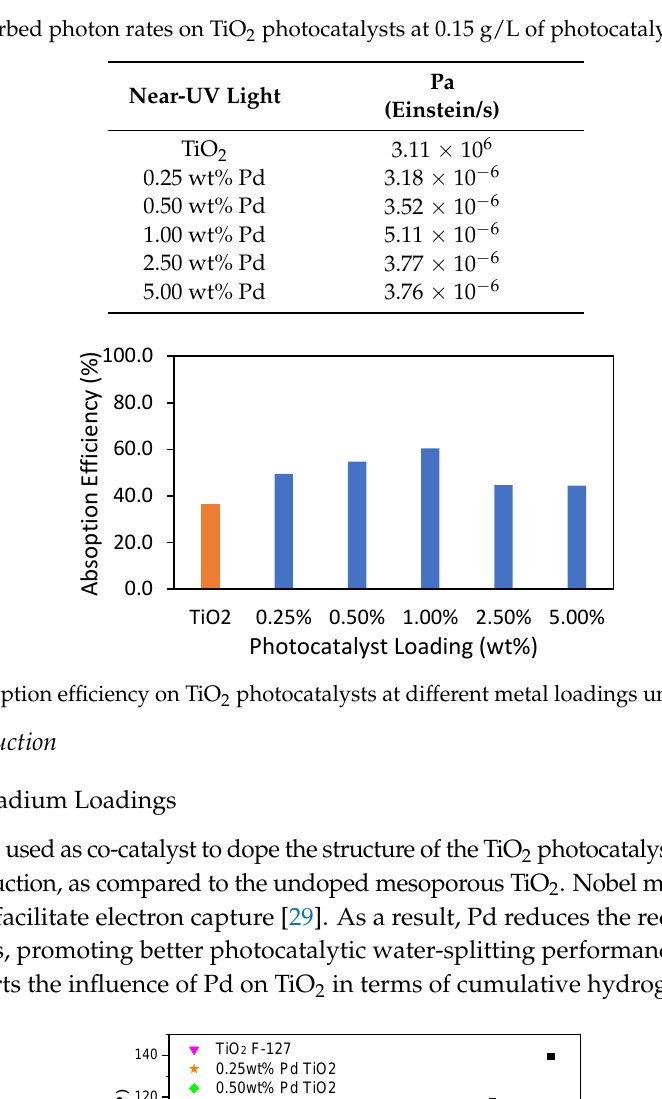
Table 4. Absorbed photon rates on TiO 2 photocatalysts at 0.15 g/L of photocatalyst concentration.